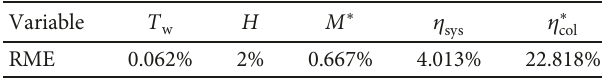
Table 3: Experimental RMEs of all